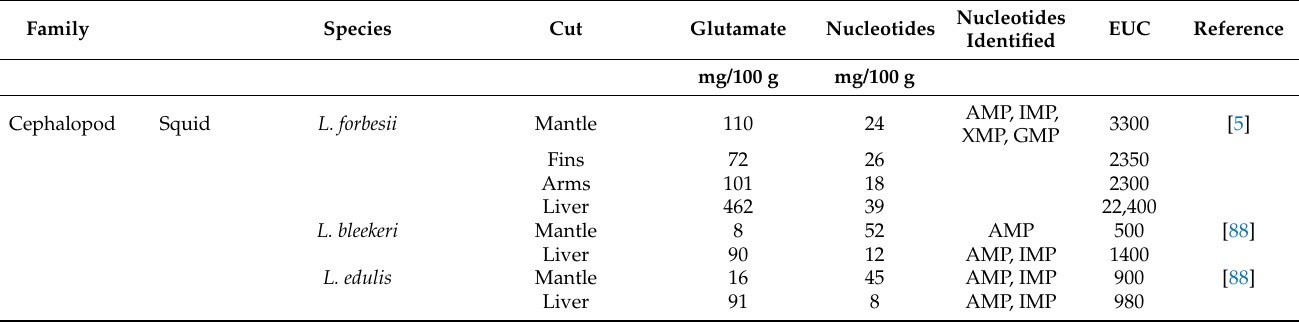
Table 3. Overview table of umami taste compounds in different species of cephalopods and other marine sources of protein. EUC denotes effective umami concentration [87] that describes the synergy of simultaneous presence of free glutamate and free nucleotides in the sample. Nucleotides Species Cut Glutamate Nucleotides